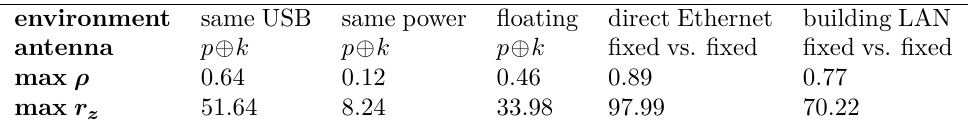
Table 6: Comparison of different connection